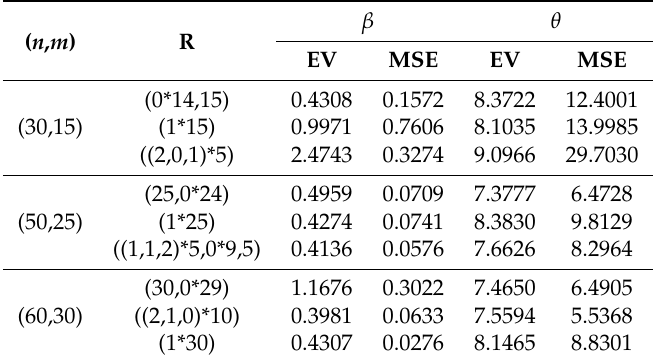
Table 7. EVs and MSEs of Lindley approximation for ( 0.5,7 ) when T =